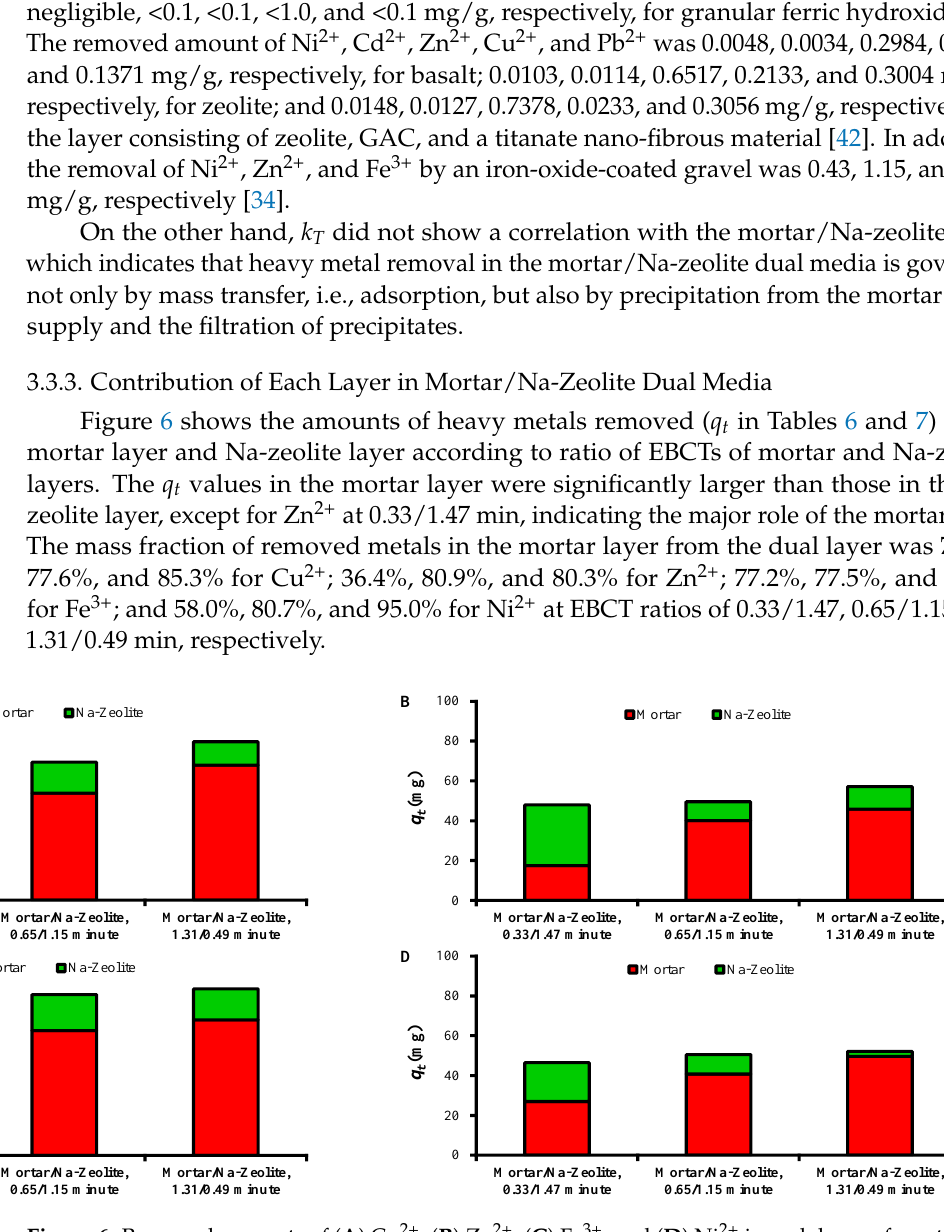
Figure 6. Removed amounts of ( A ) Cu 2+ , ( B ) Zn 2+ , ( C ) Fe 3+ , and ( D ) Ni 2+ in each layer of mortar/Na- zeolite dual media for different ratios of EBCTs.